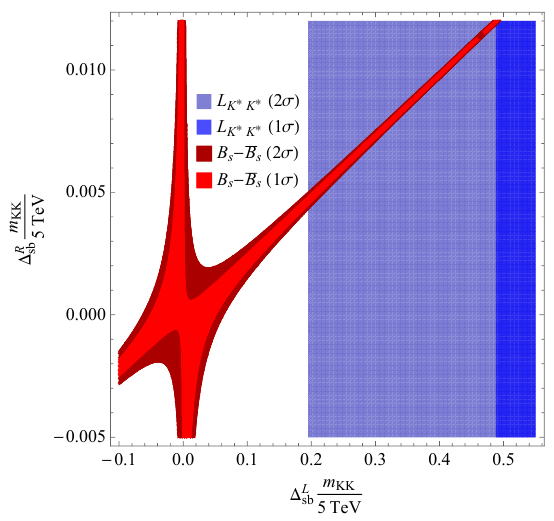
Figure 3 . Preferred regions from B s − ¯ B s mixing (red) and L maximal value of ∆ L compatible with LHC searches assuming real couplings. Note that explaining qq L requires some fine-tuning in ∆ L vs ∆ R K ∗ ¯ K ∗ sb sb